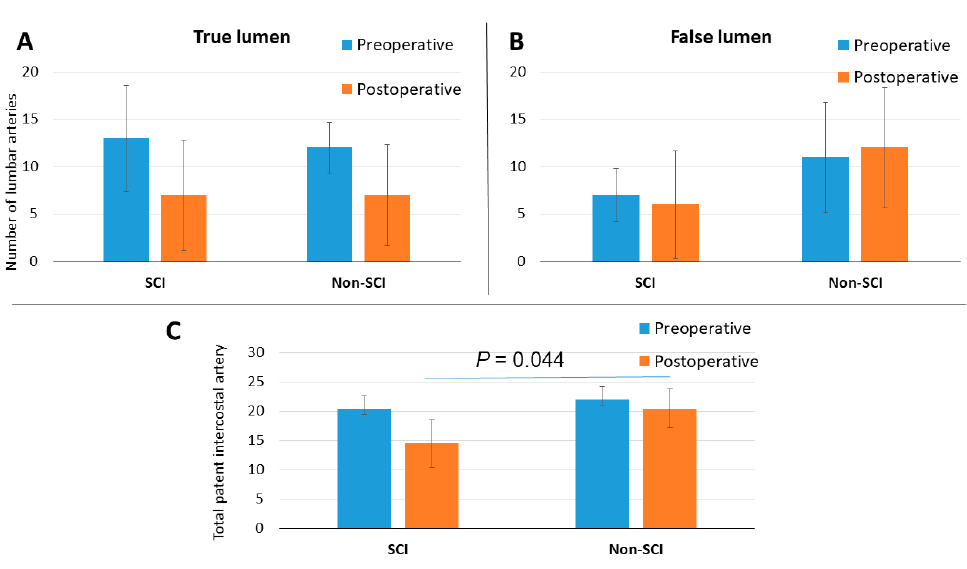
Figure 1. Ratio of patent posterior intercostal arteries before and after FET: ( A ) vessels originated from true lumen; ( B ) vessels originated from false lumen; ( C ) all posterior intercostal arteries.